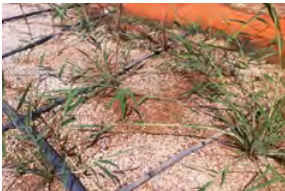
Figure 3. vertical-alternating –flow ( in the pilot scale )